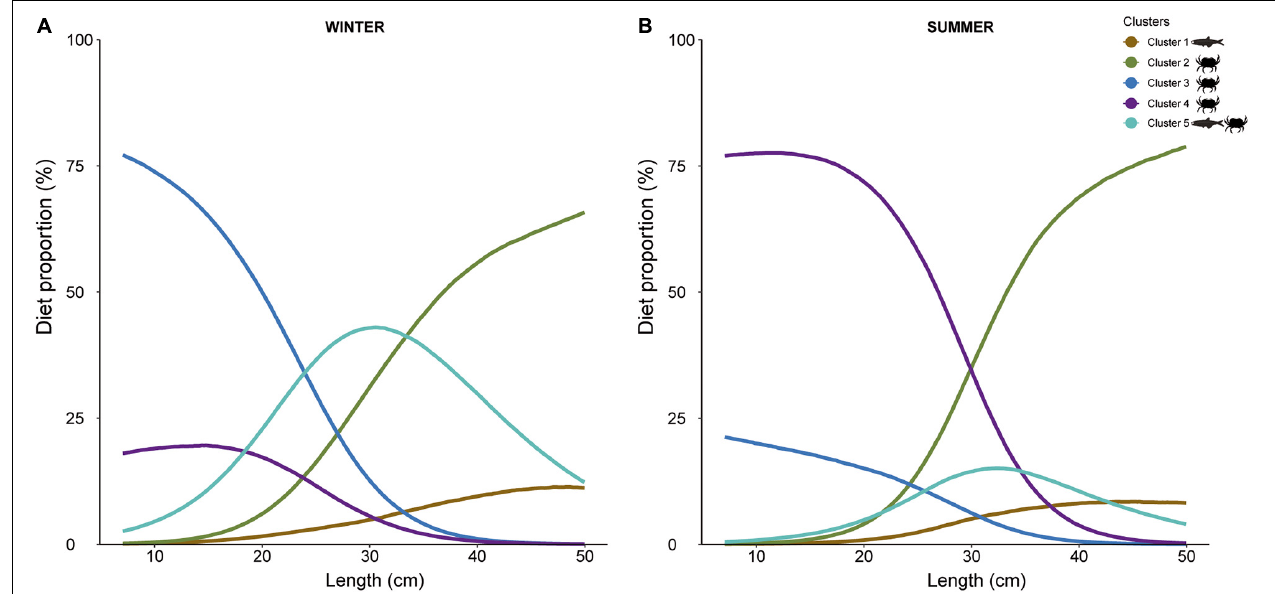
FIGURE 6 | MixSIAR model results showing estimated diet proportions of each potential prey clusters (1, 2, 3, 4, and 5) contributing to European hake diet, as a function of length (in cm) for each season ( (A): winter and (B): summer). Cluster 1 : Cepola macrophthalma, Boops boops, Spicara maena, Spicara smaris, Argentina sphyraena, Trisopterus minutus, Lepidopus caudatus, Sardina pilchardus, Maurolicus muelleri, Gadiculus argenteus, and Micromesistius poutassou , Cluster 2 : Chlorotocus crassicornis , Nematoscelis megalops, and Phronima sedentaria , Cluster 3 : Vibilia armata , Cluster 4 : Anchialina agilis and Meganyctiphanes norvegica, and Cluster 5 : Engraulis encrasicolus, Plesionika heterocarpus, Sardinella aurita, and Solenocera